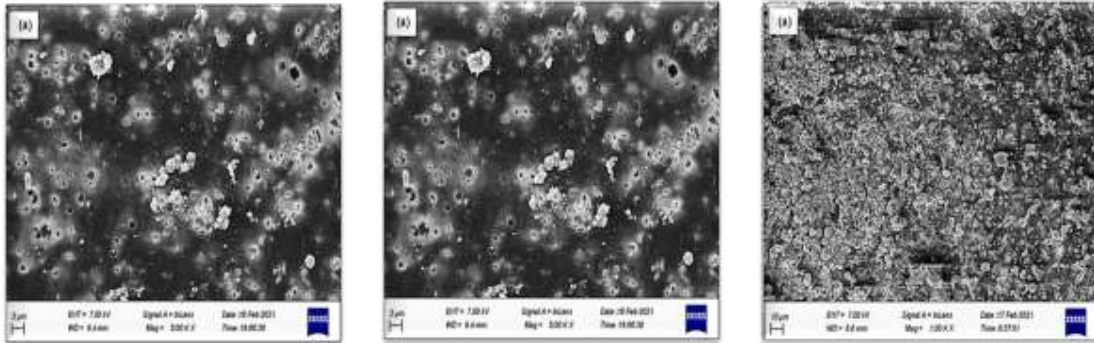
Figure 4: SEM images of a. Pc, b. Pc0.1, and c.